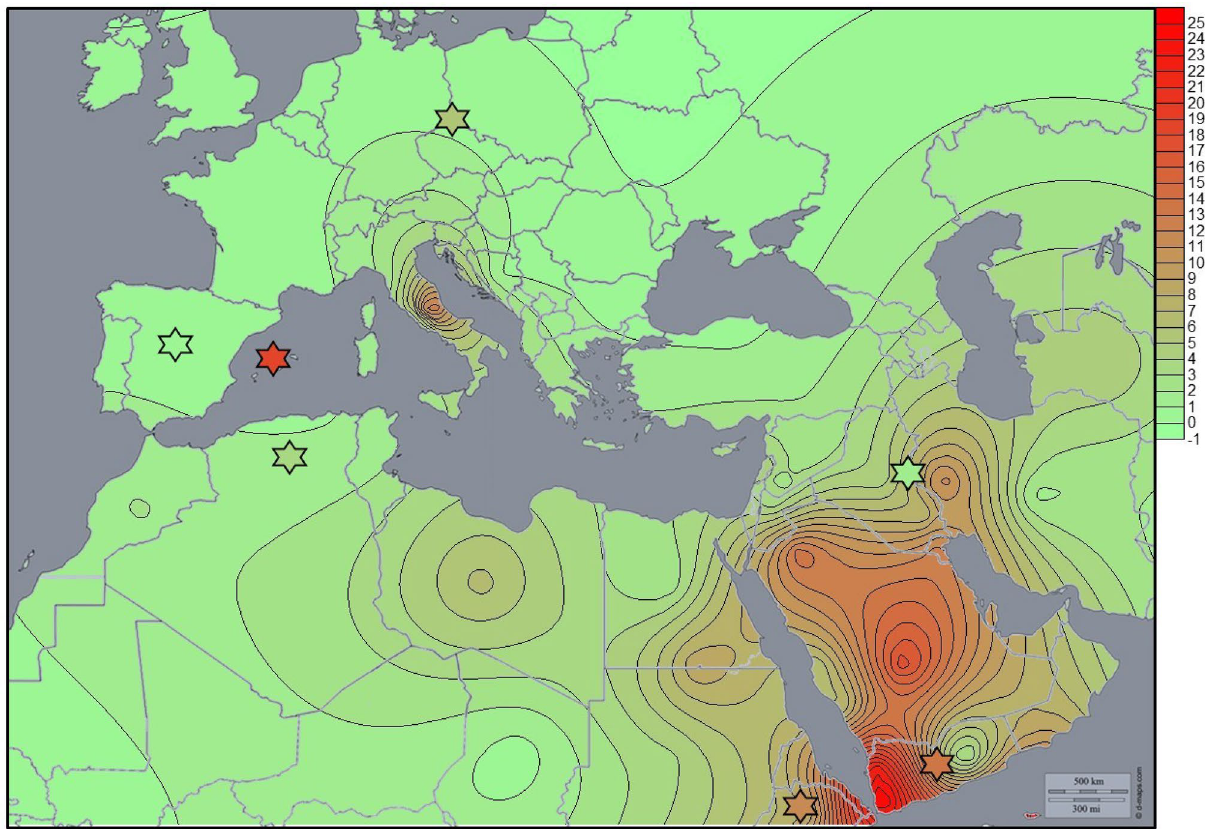
Figure 5. Isofrequency map of haplogroup R0a based on data from the literature (Supplementary Table 5) generated by Surfer v.8 (Golden Software Inc., Golden, Colorado) using a base map image (http: d-maps.com). Jewish populations are indicated with a Star of